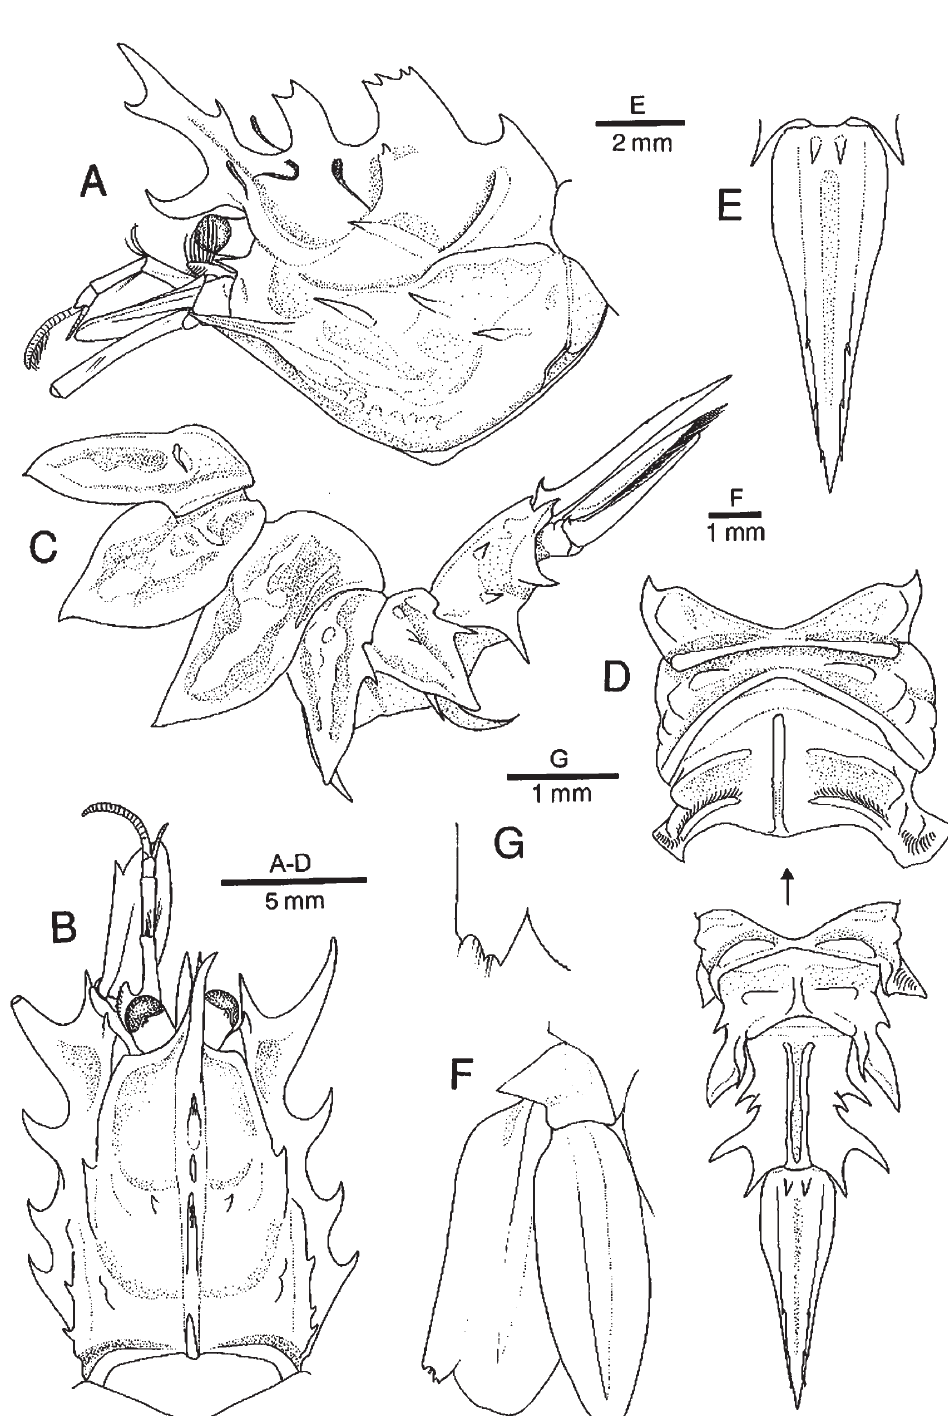
Description : Rostrum (Figs. 5A, 6A-C) straight, 0.60-1.00 times as long as carapace (0.60-0.70 times in spawning females); dorsal margin with 1 or PARACRANGON FROM THE NORTHWESTERN PACIFIC